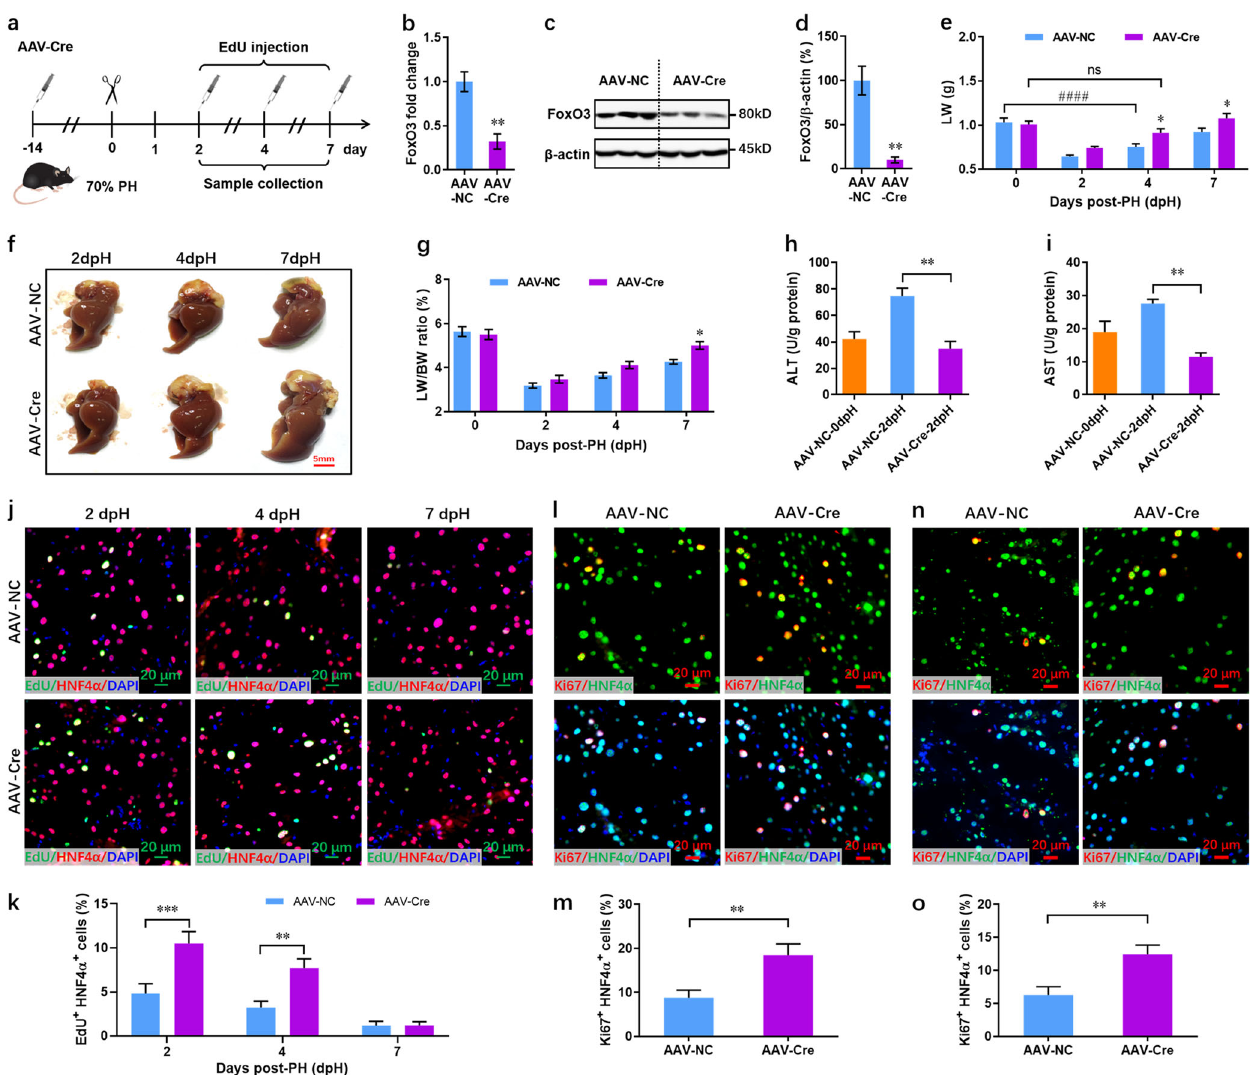
Fig. 5 Conditional loss of FoxO3 only in adult mice promotes liver regeneration via hepatocyte proliferation. a Schematic of AAV-Cre injection in adult FoxO3 fl / fl mice followed by PH performance and EdU injection at individual time points. b qPCR validation of FoxO3 expression in livers from AAV-Cre and control mice ( n = 3 mice). c , d Representative western blot images ( c ) and quanti fi cation ( d ) of FoxO3 expression in primary hepatocytes. e Recovery of liver weight in control and AAV-Cre mice after PH ( n = 10 mice per group). f